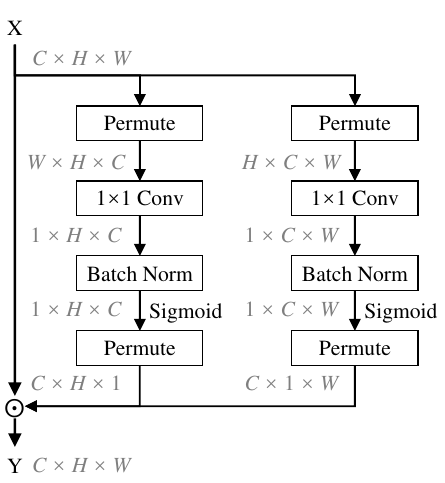
Figure 3. Spatial channel attention mechanism (SCA), where (cid:12) denotes broadcast elementwise